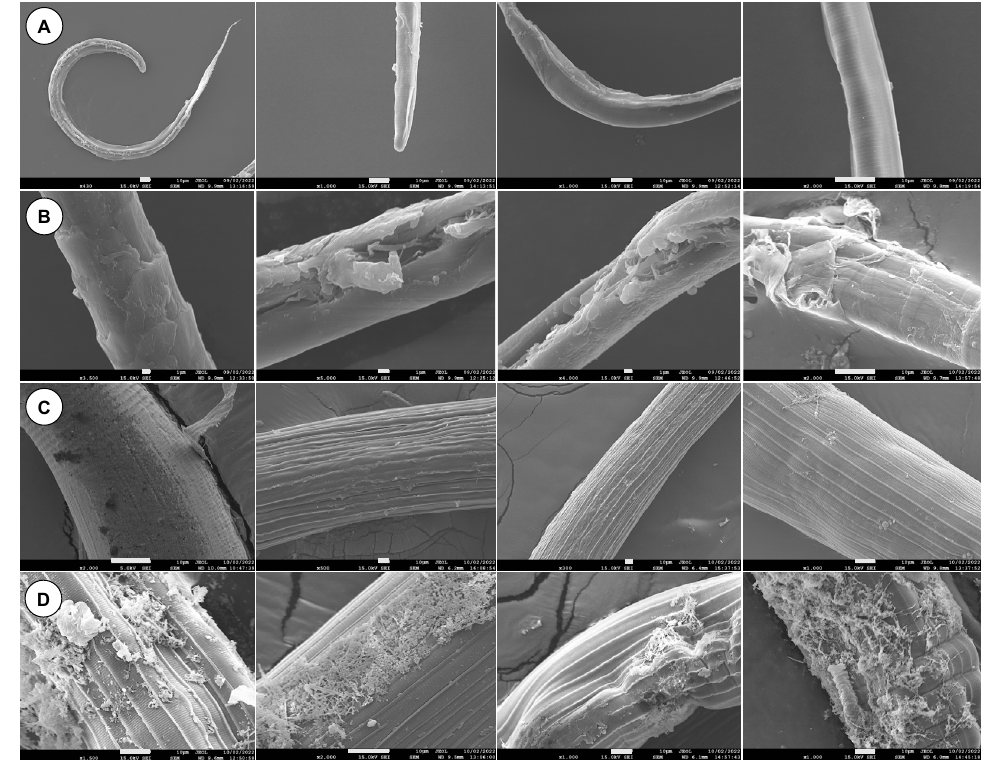
Figure 16. SEM micrographs of parasite stages treated with CS-PLGA particles loaded with combined EO components. ( A ) Negative control larvae (Scale bar = 10 μ m). ( B ) Treated larvae (Scale bar = 1 μ m). ( C ) Negative control adult worms (Scale bar = 10 μ m). ( D ) Treated adult worms (Scale bar = 10 μ m).